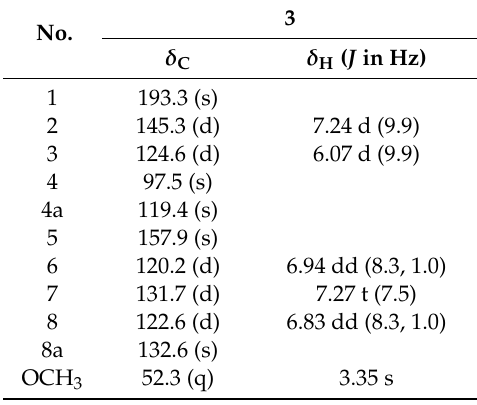
Table 2. 1 H (500 MHz) and 13 C-NMR (125 MHz) Data of Compounds 3 (in CDCl 3 ).